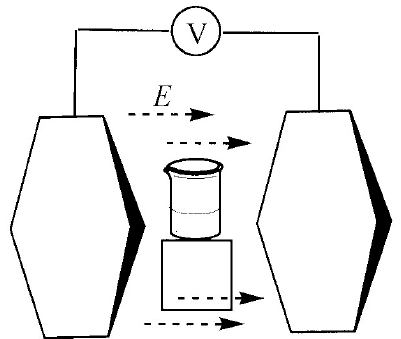
Figure 2. The polymerization scheme under the electric field.